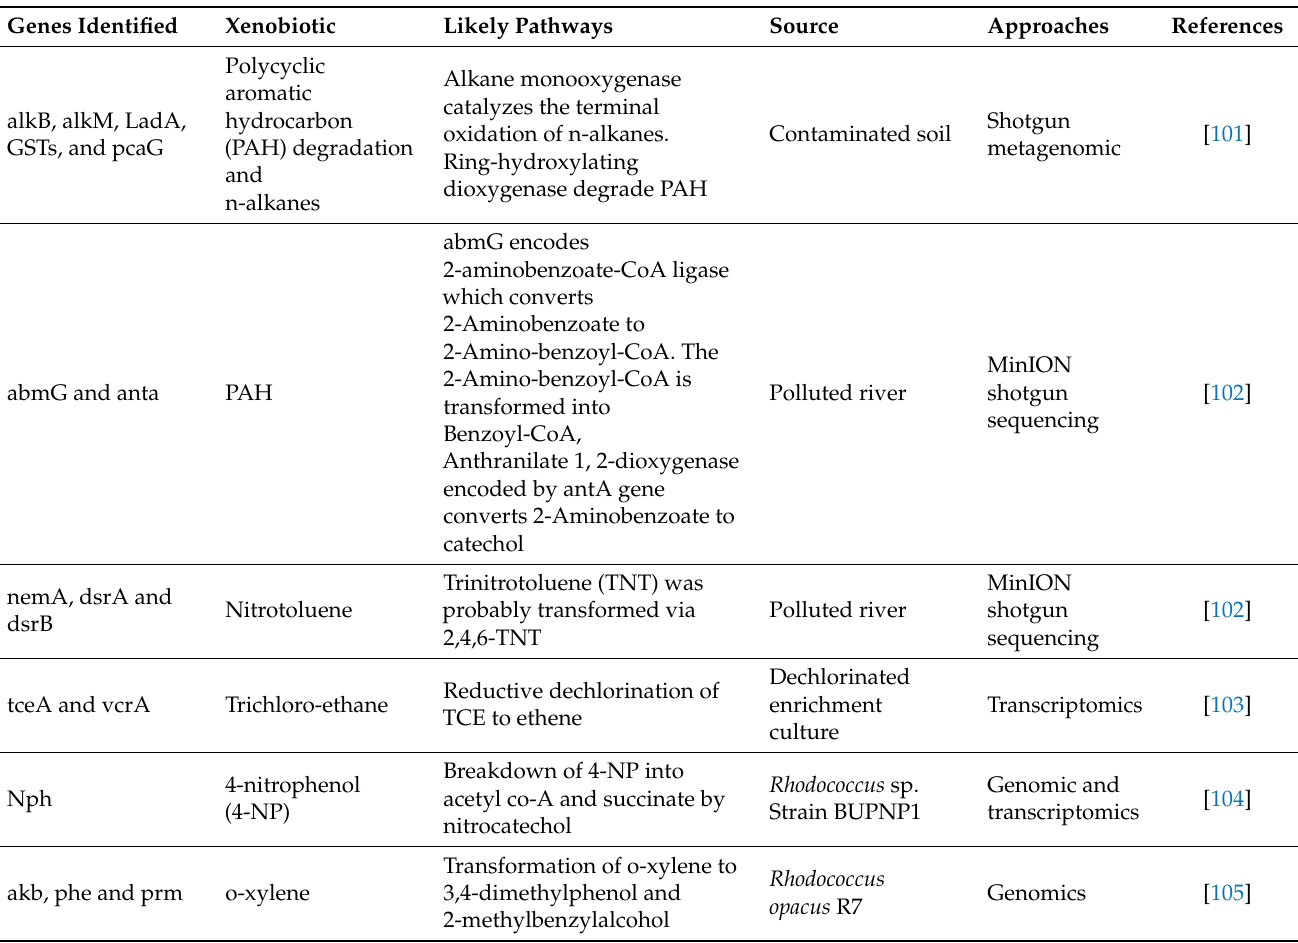
Table 2. List of catabolic genes identified recently for xenobiotic pollutants through various omics